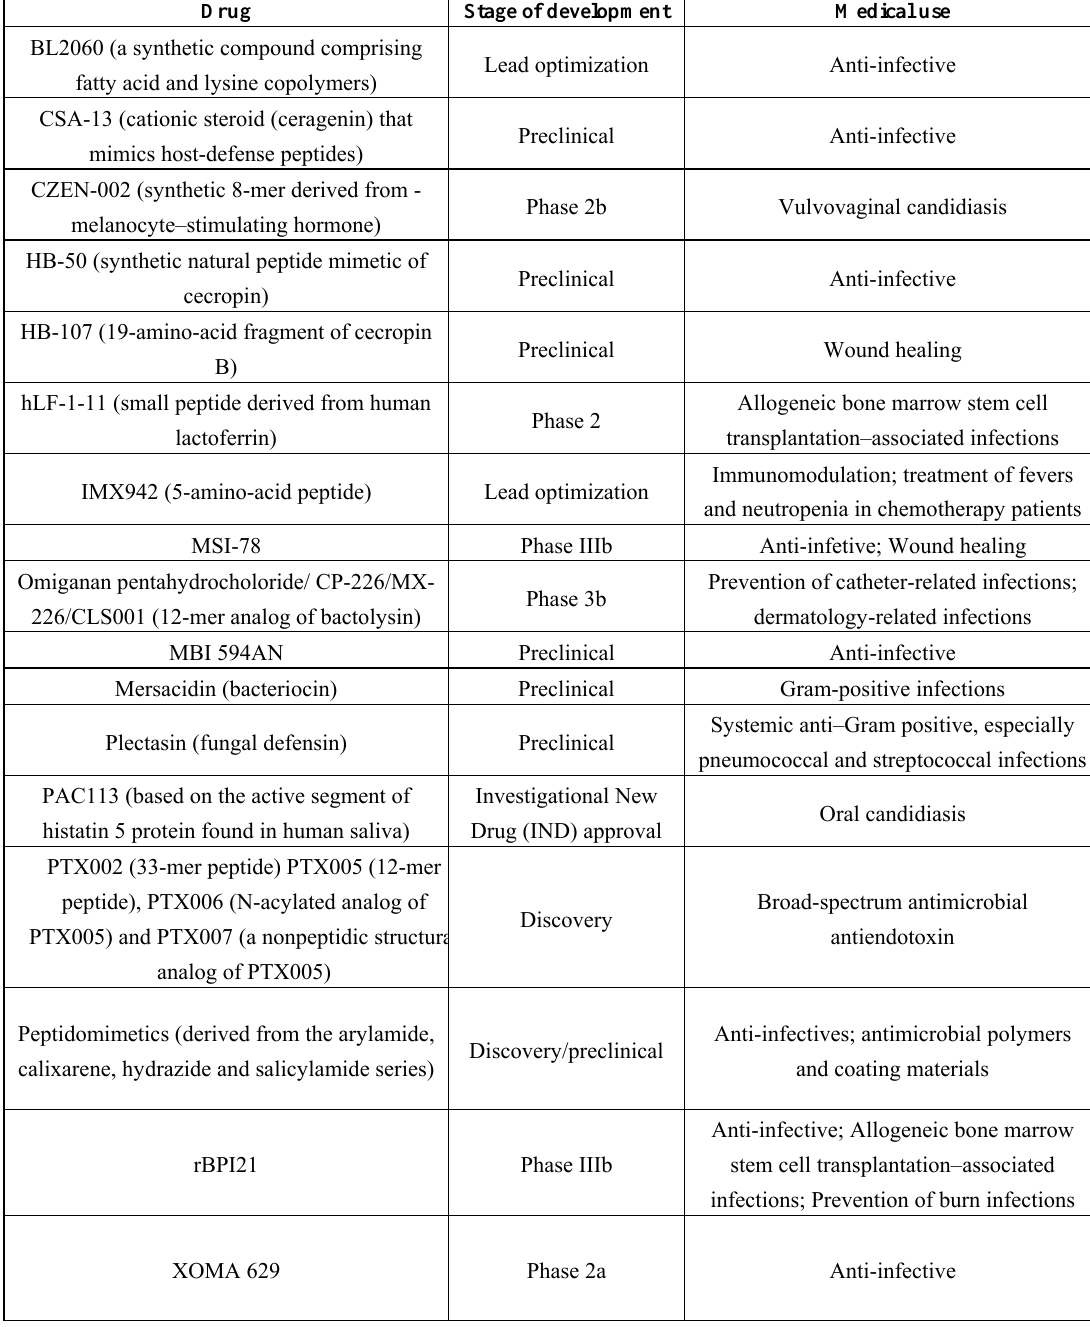
Table 2. Host defense deptides in commercial